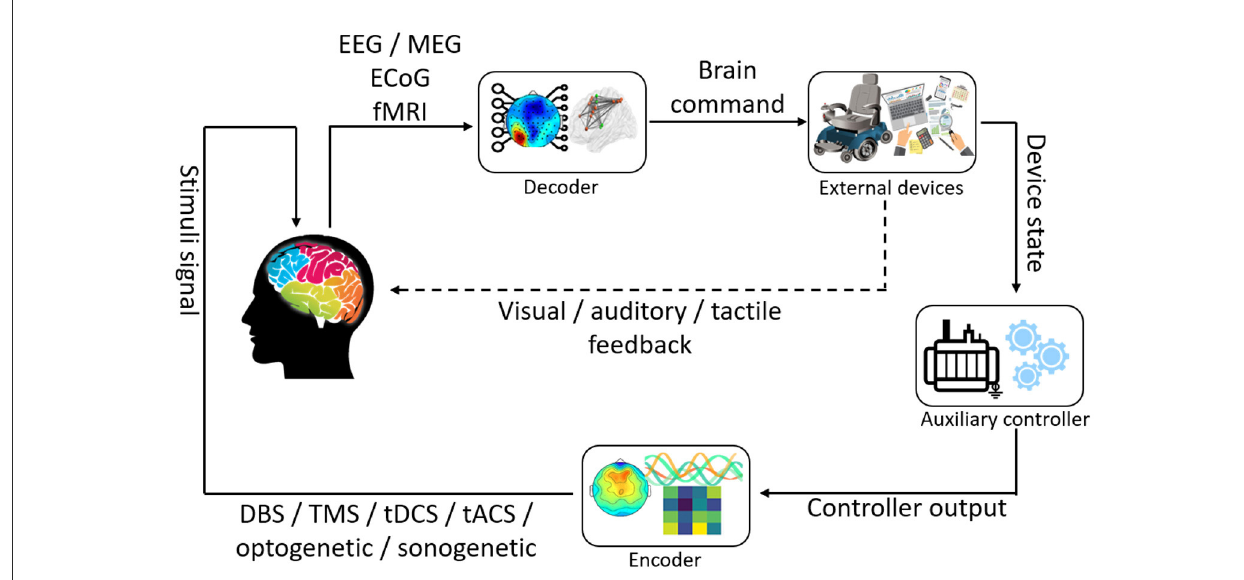
FIGURE1 The closed-loop system based on brain stimulation with feedback.